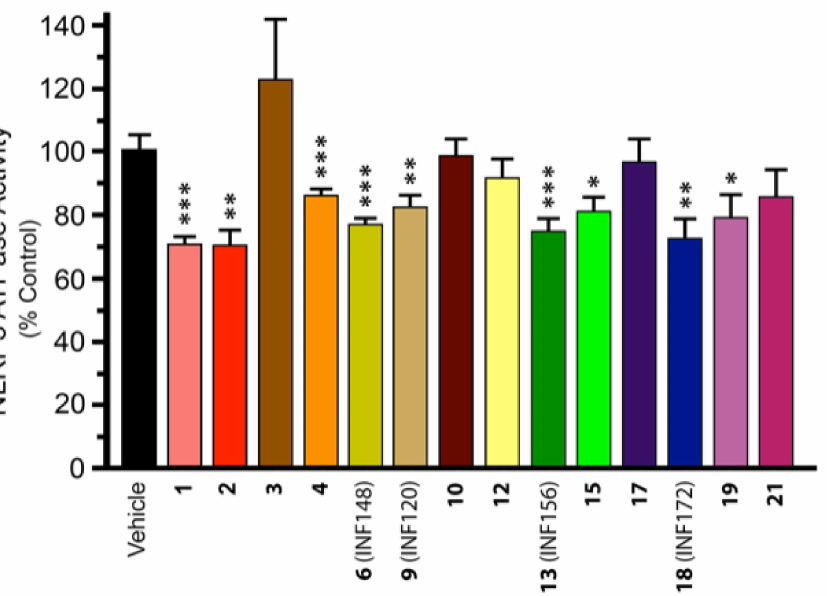
Figure 4. Inhibition of NLRP3 ATPase activity by selected compounds. Inhibition was calculated from the relative luminescence units (RLU) obtained with each compound/RLU of vehicle control. All compounds were added at concentrations of 100 µ M and the ATP concentration in all assays was 800 µ M. Mean ± SEM; Significantly different from vehicle control using unpaired Student’s t -test with Welsch’s correction. * p ≤ 0.05, ** p ≤ <0.005, *** p ≤ 0.0005; n = 4 assays per